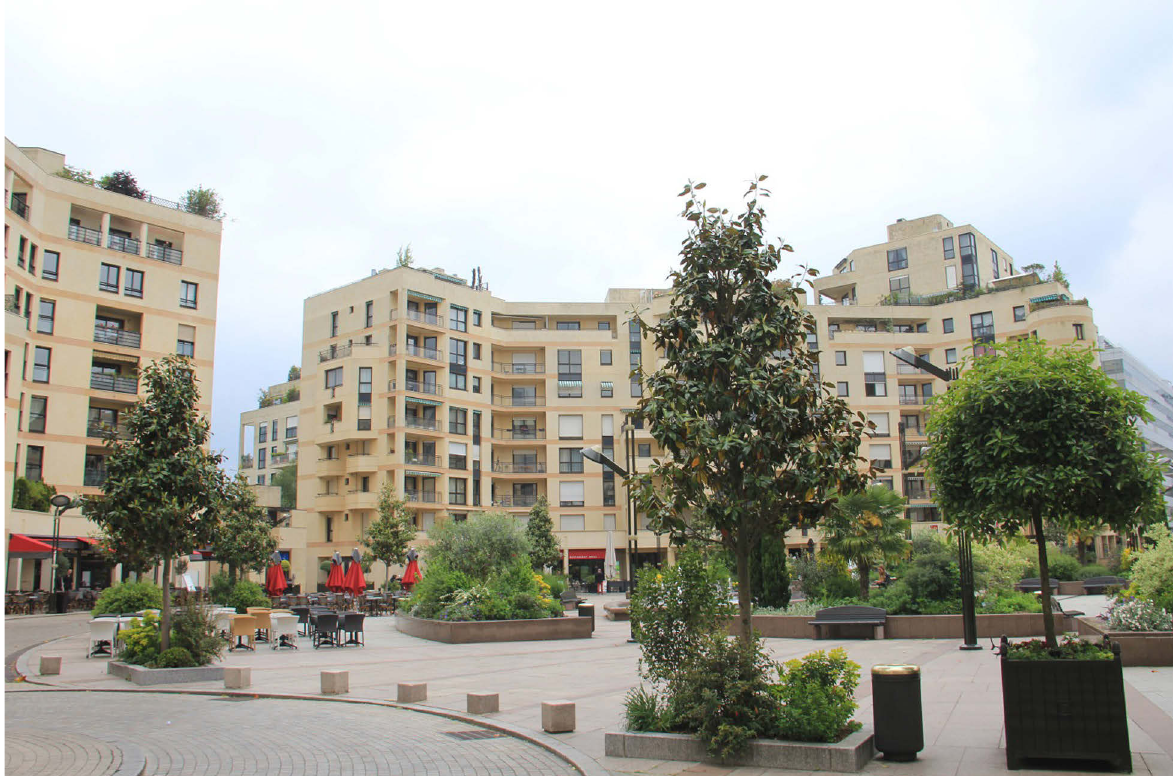
Fig. 3. Postmodern blocks where Citroën factory buildings once stood (photo: Florian Weber